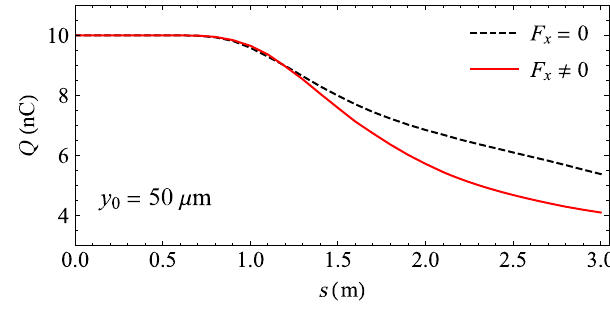
FIG. 11. Bunch charge as a function of propagation distance through the structure. Plots are shown for F x removed (dotted line) and included (solid line). The beam is on the structure axis.